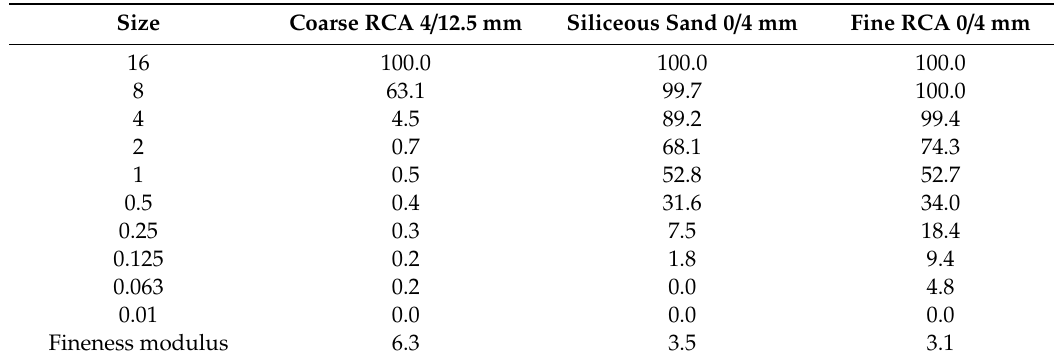
Figure 1. Aggregates’ sieve analysis. Table 2. Gradation of the aggregates (EN 933-1